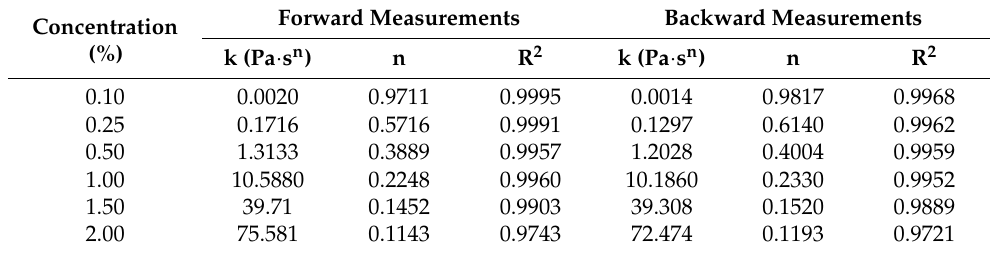
Figure 5. Flow curves of Yanang gum at different concentrations by increasing and decreasing the shear rate. ( (cid:3) ) 0.10%, ( ∆ ) 0.25%, (o) 0.50%, ( ♦ ) 1.00%, ( (cid:7) ) 1.50%, ( • ) 2.00%. ( a ) Forward measurements (increasing the shear rate); ( b ) Backward measurements (decreasing the shear rate). Table 3. Rheological parameter of the power law model of Yanang gum at different